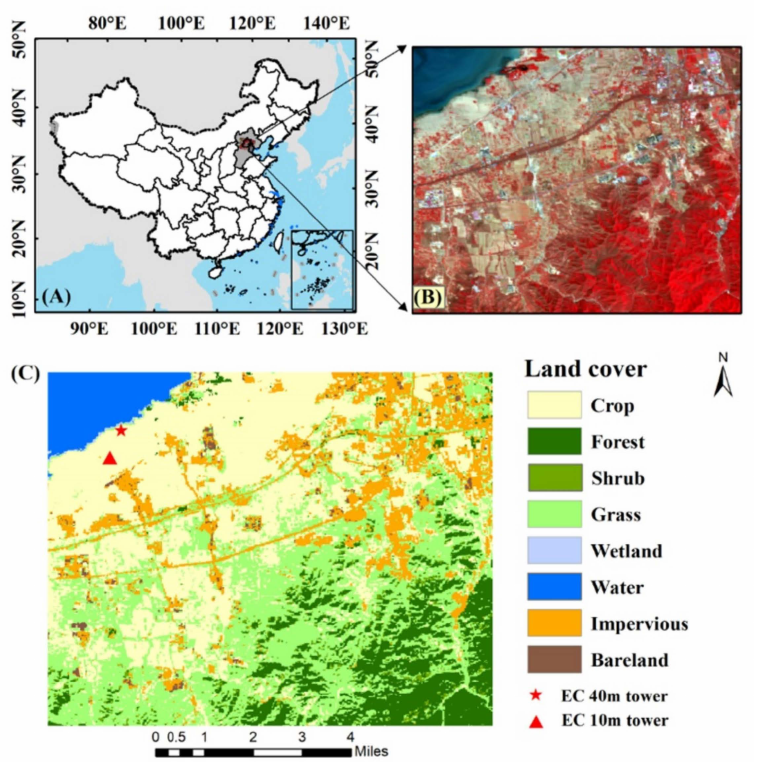
Figure 2. Maps showing: ( A ) The location of the study area; ( B ) GF-1 image collected on 2017/133; ( C ) Land cover types and the location of EC